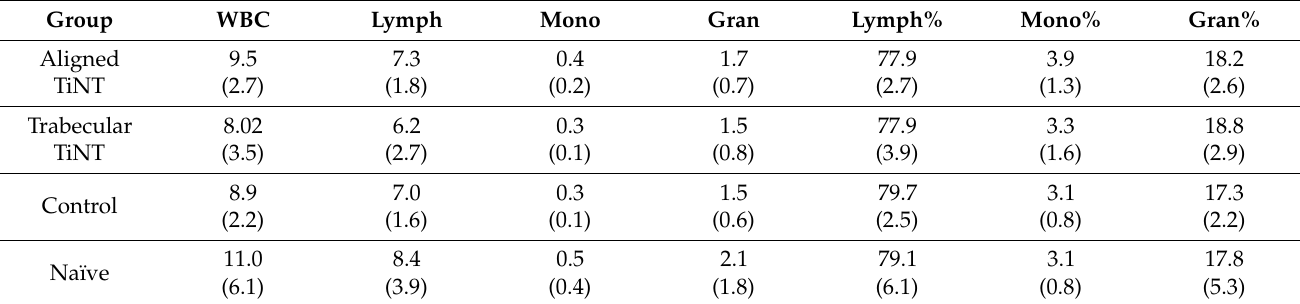
Figure 5. Average animal body weight over 12-week study ( A ) and organ weight at endpoint ( B ) per group. For Week 9, significant comparison: aligned TiNT vs. trabecular TiNT, p = 0.013; For Week 11, significant comparison: trabecular TiNT vs. control, p = 0.023. Table 1. Hematologic analysis of white blood cell function of each treatment group at endpoint.*